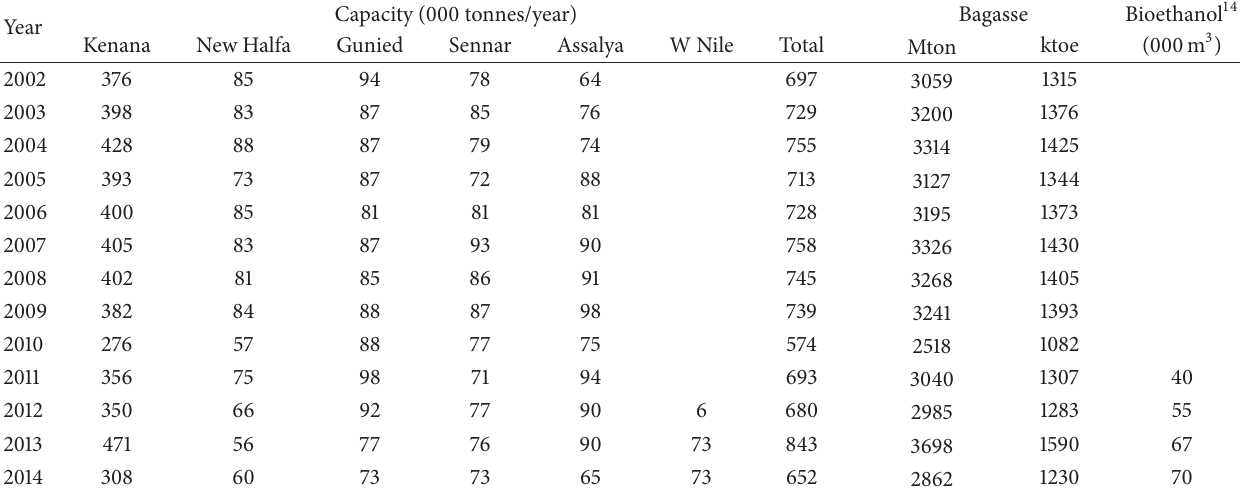
Table 18: Bagasse and bioethanol production [15].